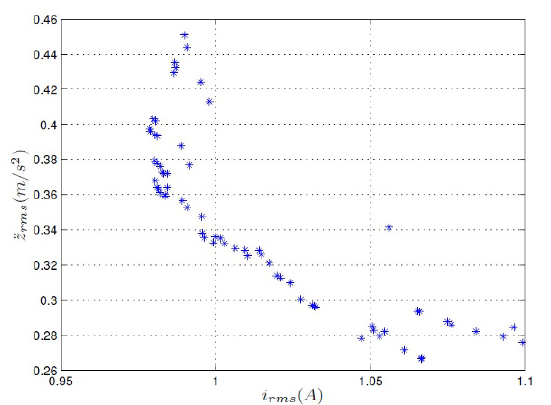
Figure 9. Real airgap (( z t − z ) r ) and input voltage ( u c ) from the de- terministic rail